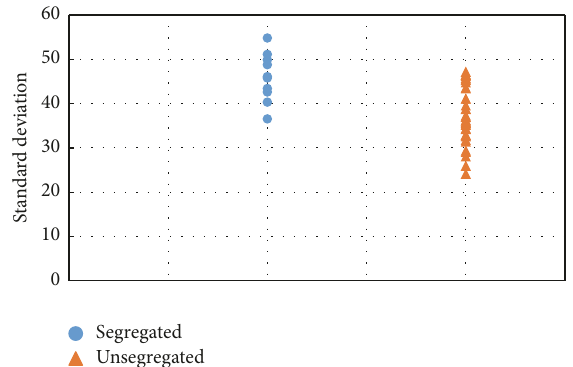
Figure 5: Frequency histogram standard deviation of both sites together.